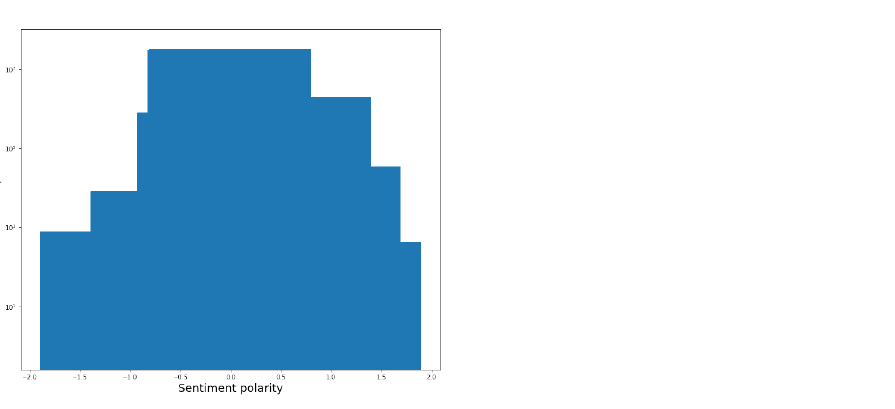
Figure 3. Distribution of posts against the sentiment polarity of their title (semi-logarithmic scale).